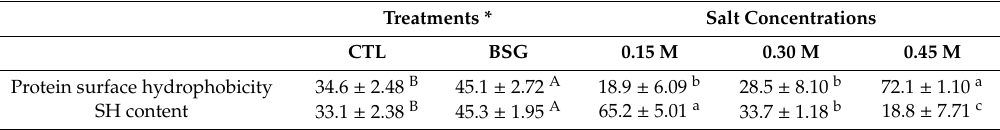
Table 4. Protein surface hydrophobicity and sulfhydryl (SH) contents of myofibrillar protein mixtures with basil seed gum at different salt concentrations.